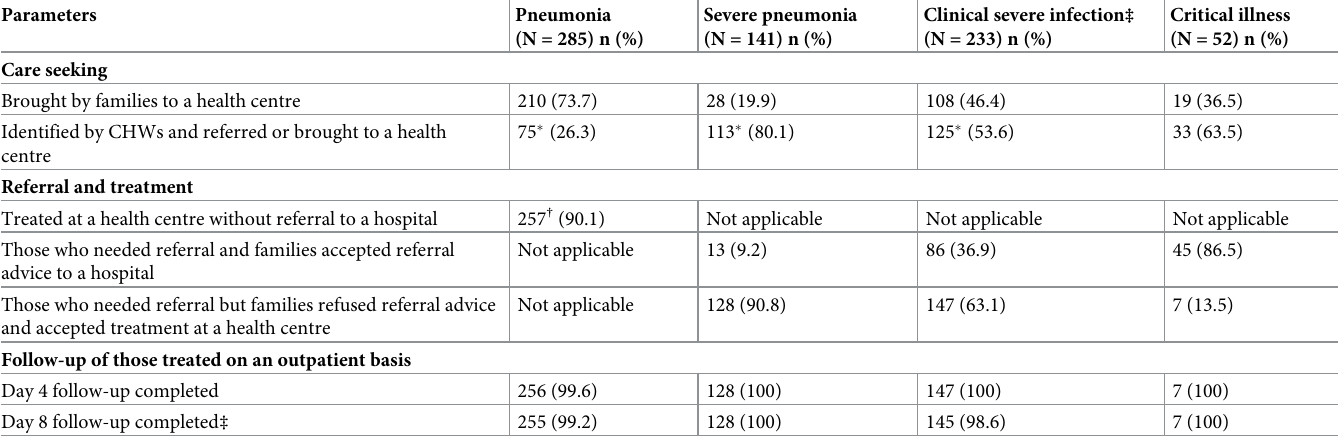
Table 3. Identification and confirmation of infants with signs of possible serious bacterial infection by health centre nurses (n = 711). Parameters